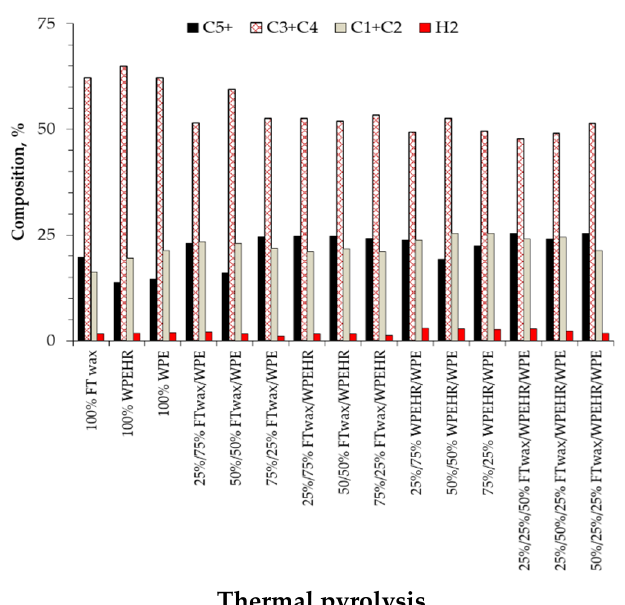
Figure 3. Composition of pyrolysis gas products.